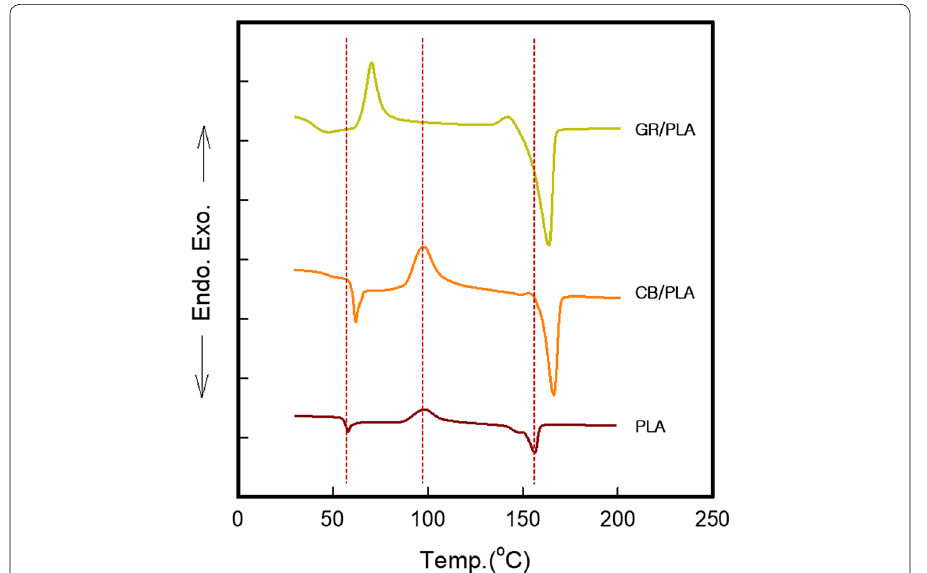
Fig. 2 DSC curves of PLA, carbon black/PLA, and graphene/PLA filament for 3D